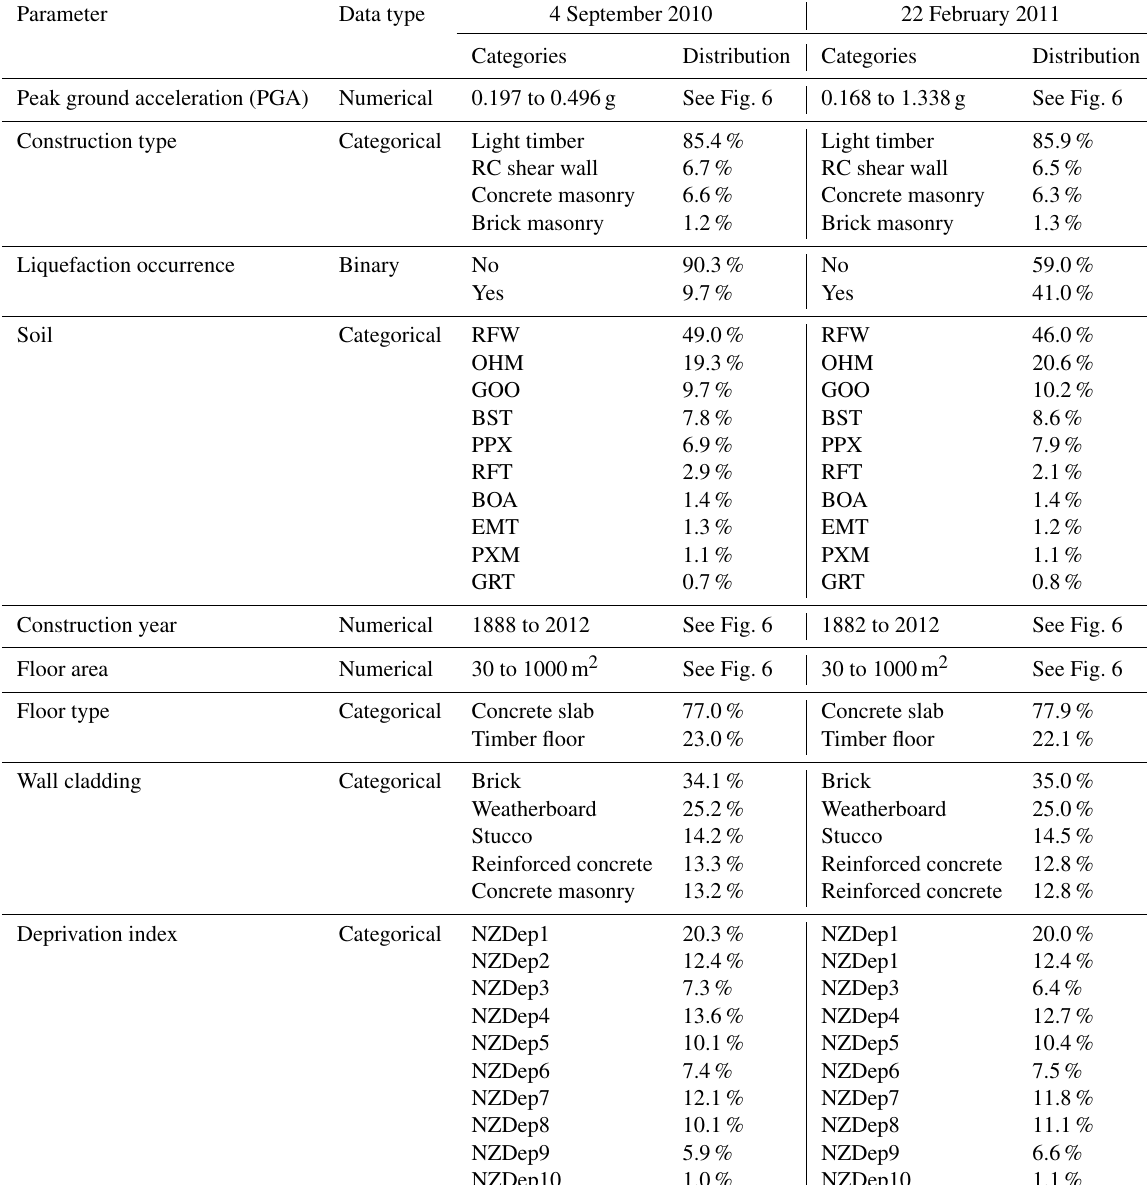
Table 2. Overview of features selected for the model with their